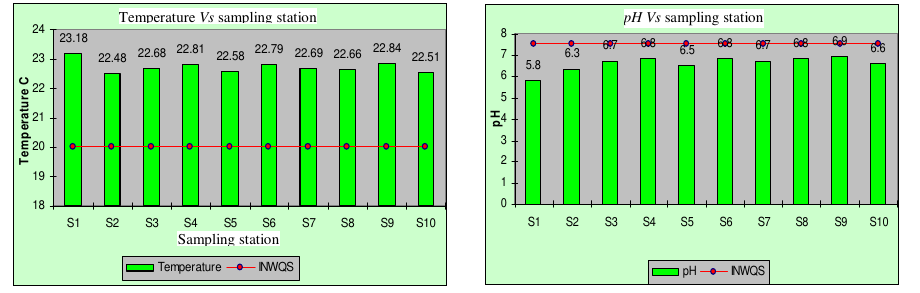
Figure 1. Temperature vs. Sampling Station. Figure 2. pH vs. Sampling Station.